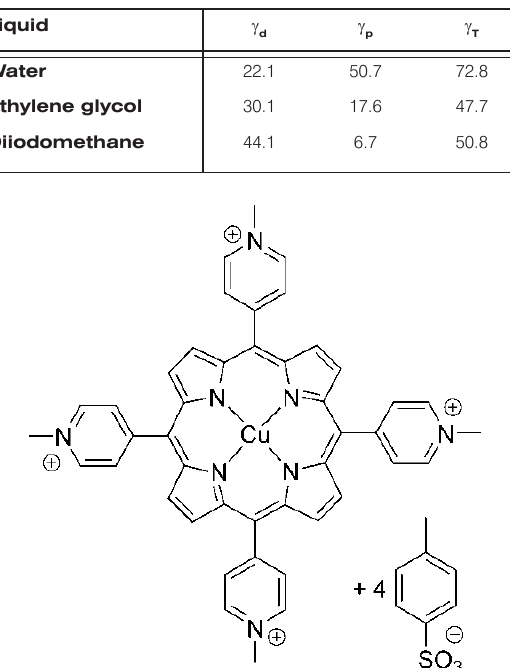
Table 1. Solvent surface tension components at 20°C (mJ m -2 ).